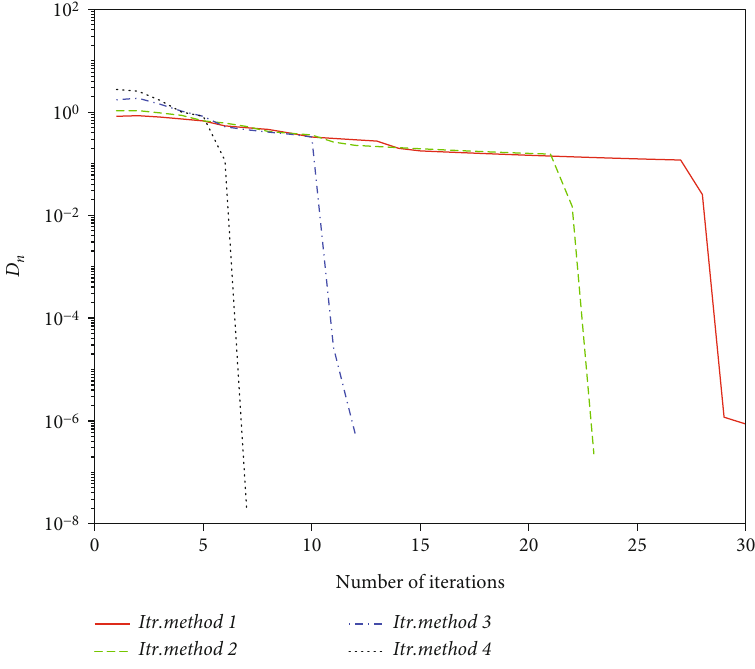
Figure 11: All methods are compared computationally while x